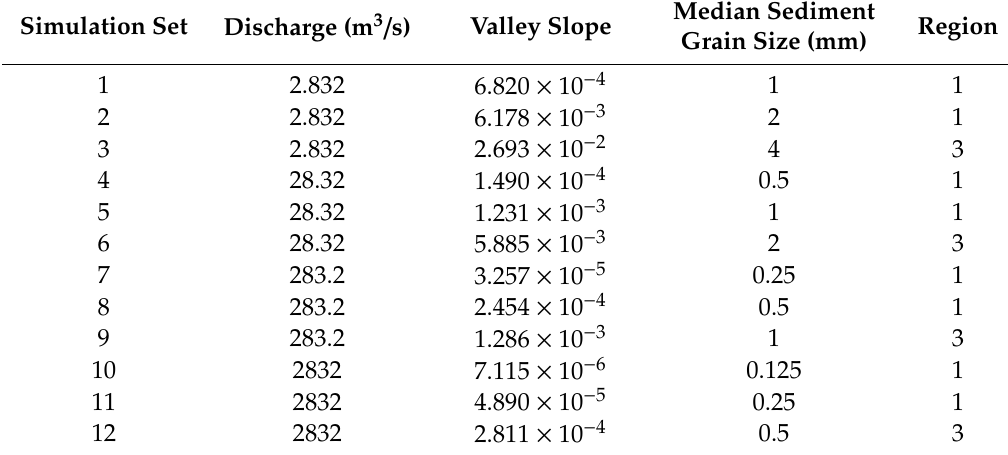
Table 1. Numerical model simulation